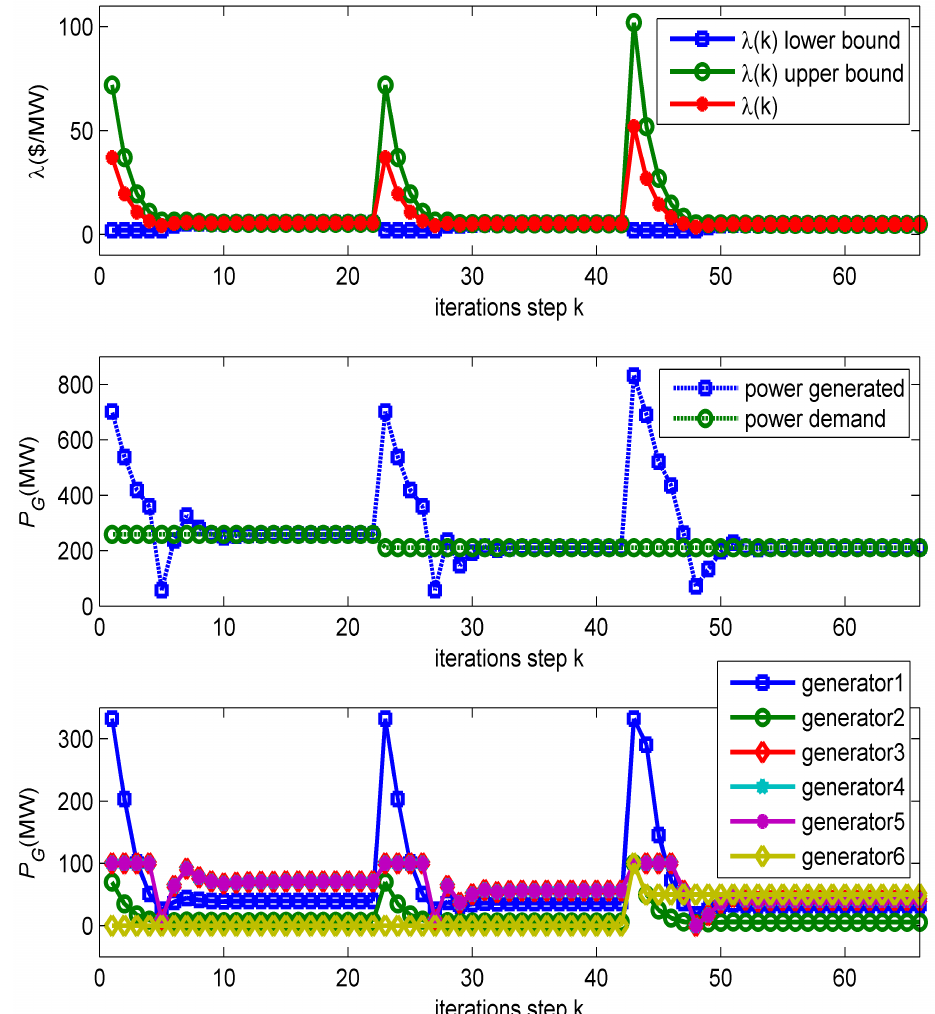
Figure 6. Case 2: Plug and play capability.